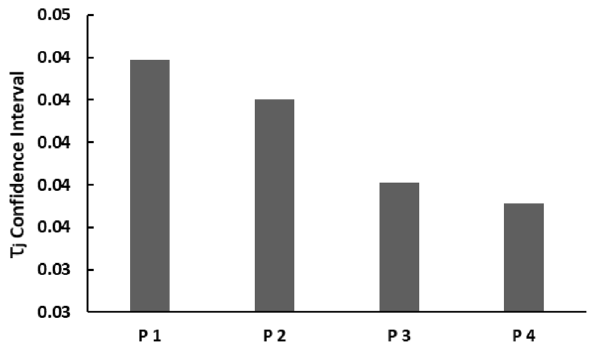
Fig. 16 95% confidence intervals on time constants ( 𝜏 j ) estimated by D-CRMP in homogeneous case III. Subscript j stands for the pro- ducer index in the range 1 to 4